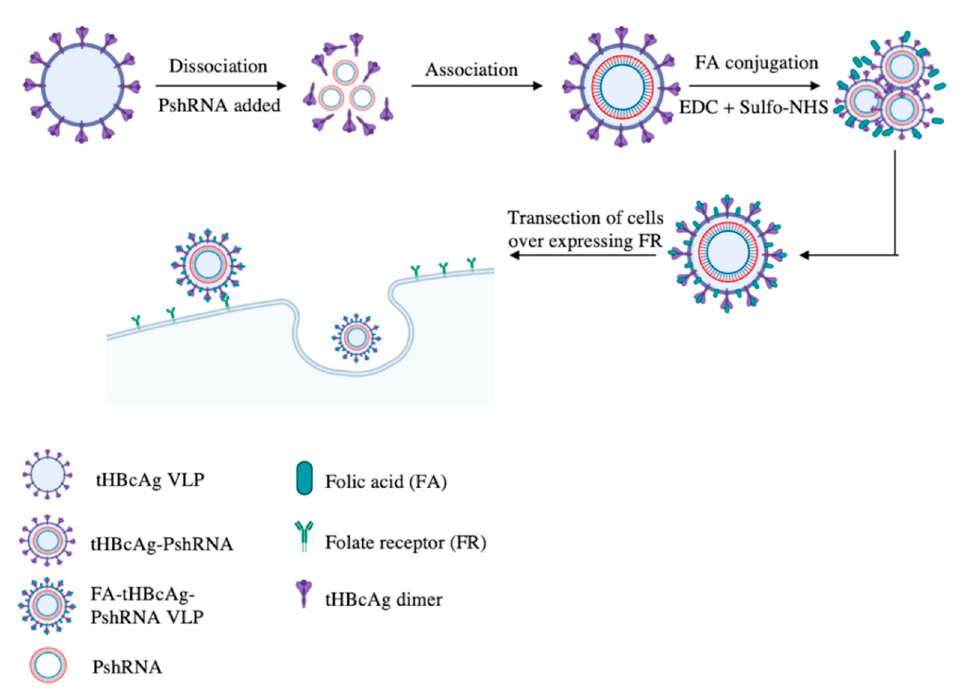
Scheme 1. Specific delivery of shRNA vectors to cells overexpressing the folate receptor using hepatitis B truncated core antigen virus ‐ like particles. Hepatitis B truncated core antigen (tHBcAg) VLPs are dissociated into tHBcAg dimers using urea. Plasmid expressing shRNA (PshRNA) is added to the dissociated tHBcAg dimers, and the urea is removed to re ‐ associate the